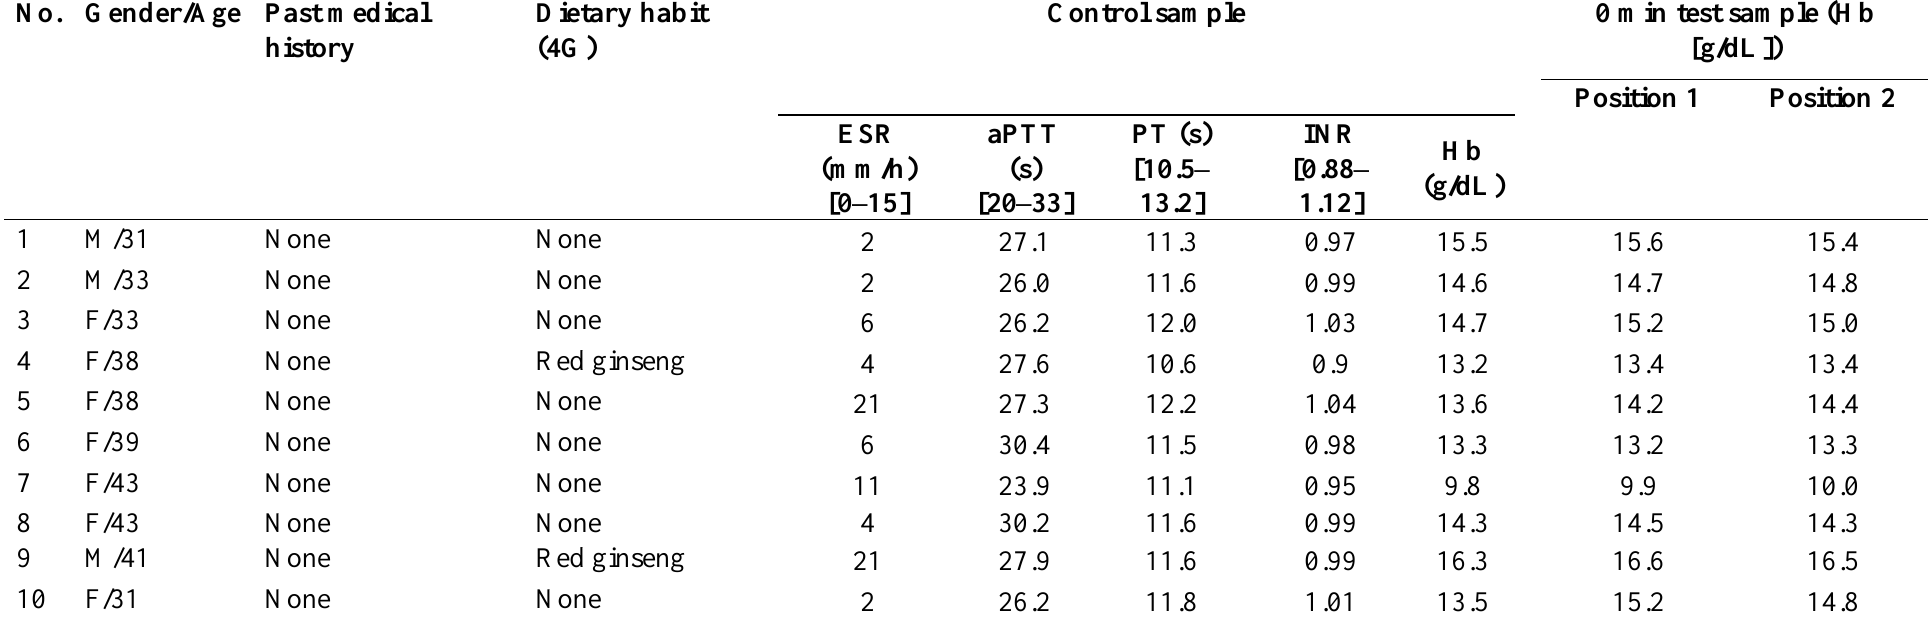
SUPPLEMENTARY TABLE 1 : Baseline characteristics of participants (April–May 2022, South